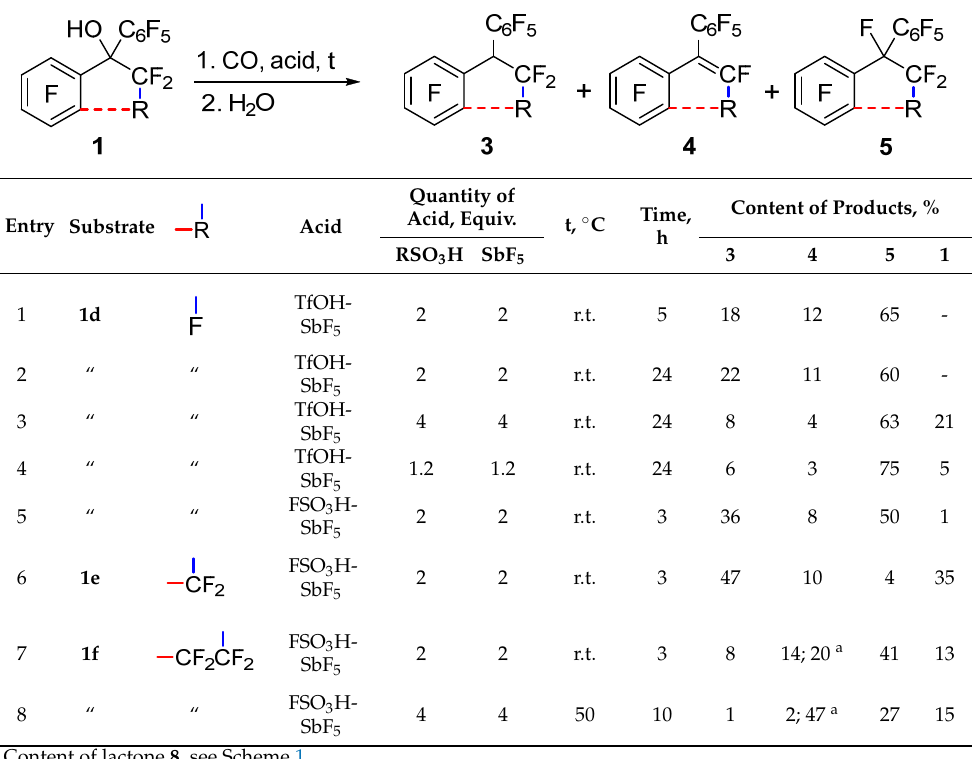
Table 2. Carbonylation of tertiary perfluorinated 1,1-diarylalkan-1-ols 1d – f in superacids.